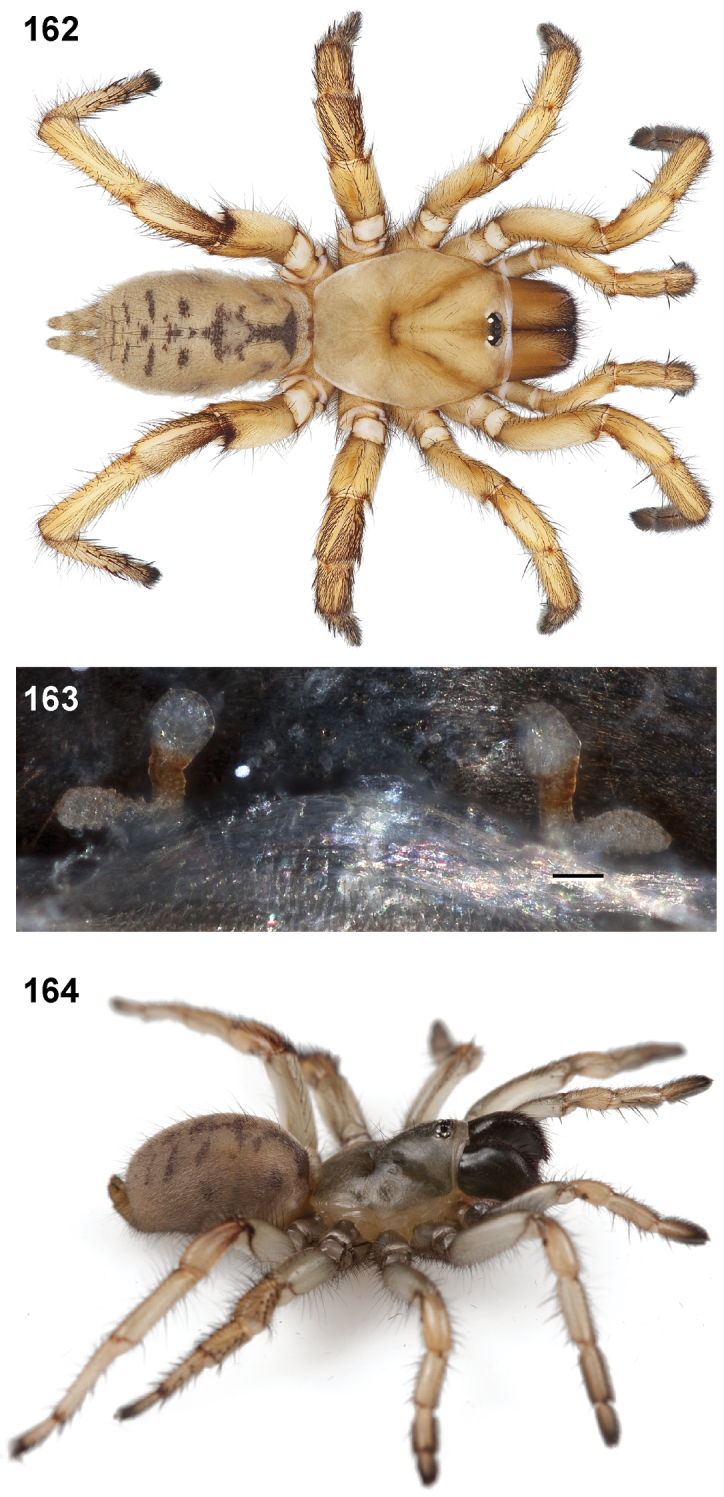
Aptostichus cabrillo female from San Diego Co., type locality. 162, 163 habitus and cleared spermathecae of paratype (MY3800) [806605]; scale bar = 0.1mm 164 live photograph (MY3801).